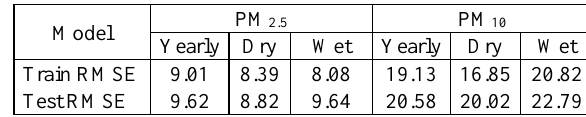
Table 4. Model error measurements of the generated PM models using gradient boosting